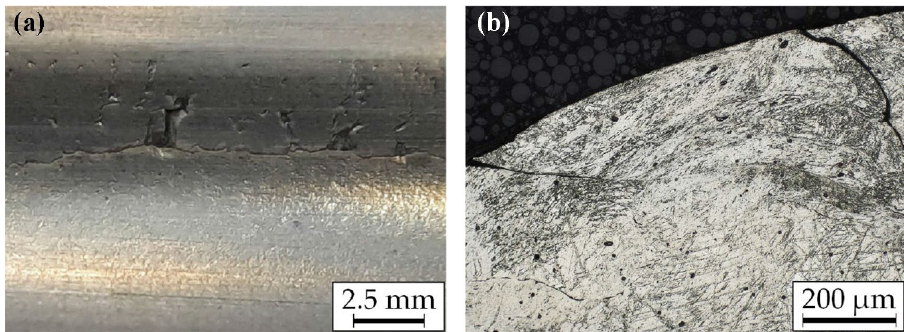
Fig. 9 Images of the automo- tive control arm showing a cracks on part surface b OM image of crack propagation in the part